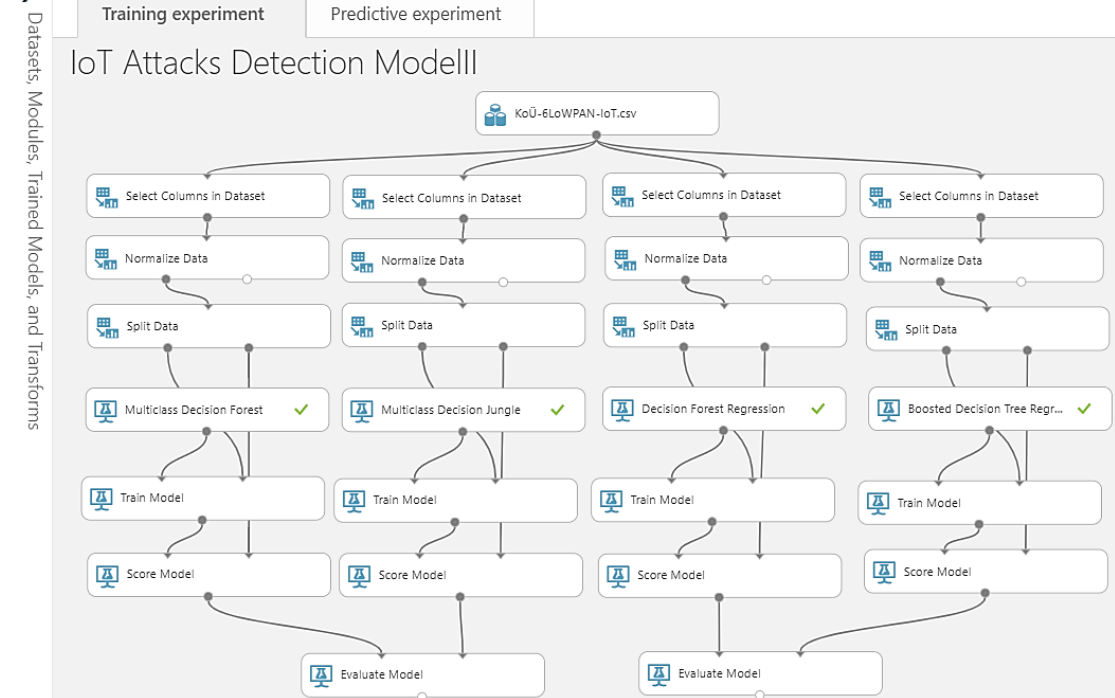
Figure 10. Decision tree-based